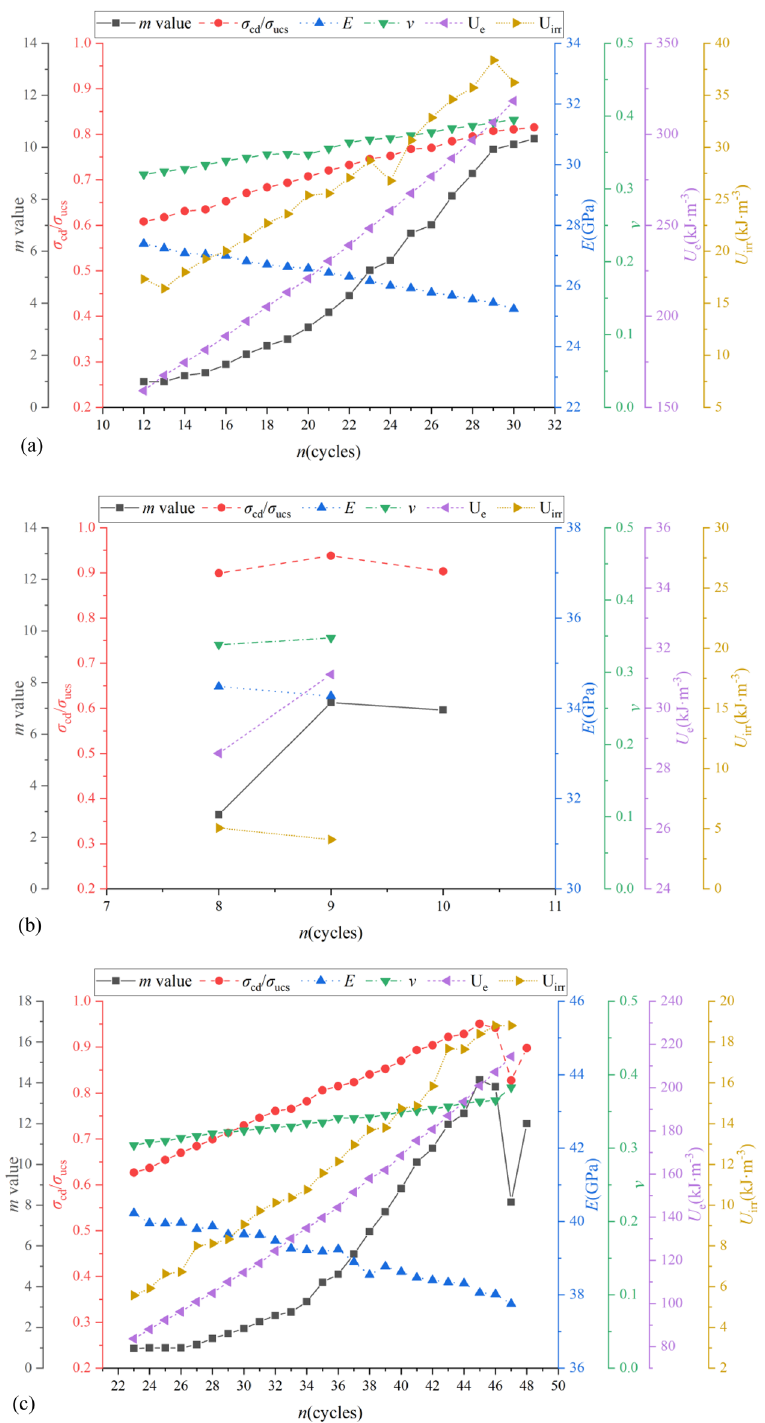
Figure 12. The relationship between m value and σ cd / σ ucs , E , ν , U e and U irr of shale specimens of group D with various dip angles: ( a ) θ = 0°; ( b ) θ = 60°; ( c ) θ =